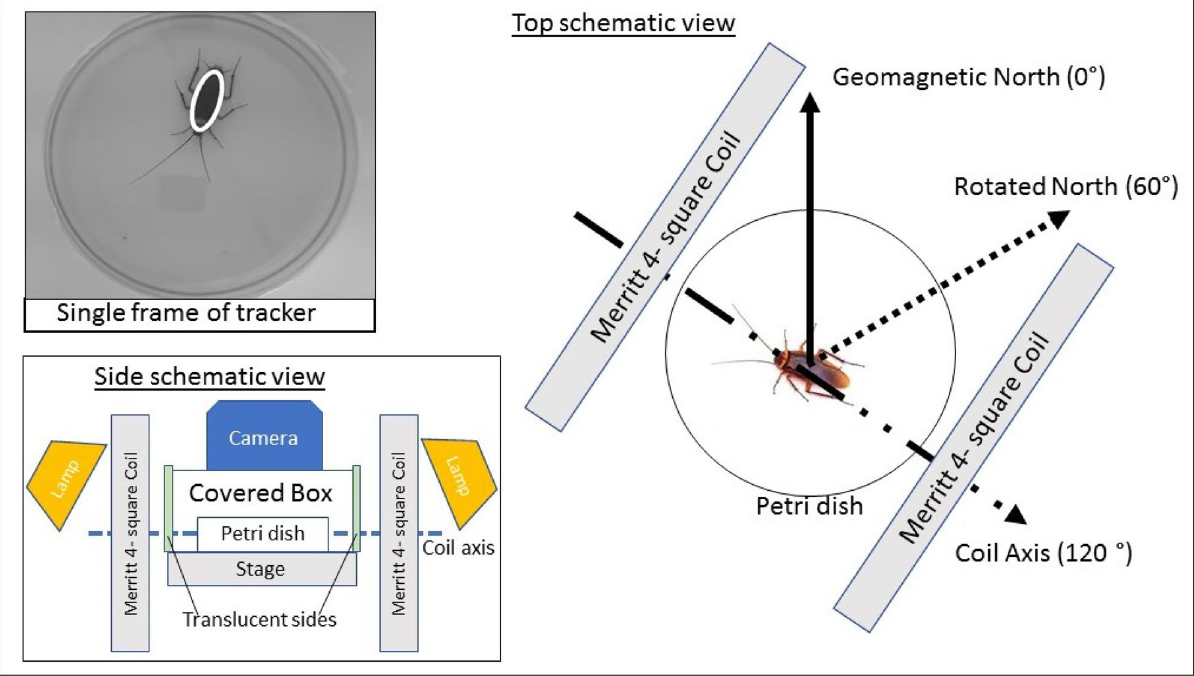
Figure 1. Schematic of experimental setup (not to scale). Cockroaches were placed in Petri dishes and levelled ◦ ± 5 ◦ inside the Merritt coil used to rotate the geomagnetic field by 60 clockwise (preserving inclination angle, i.e. only horizontal component of the geomagnetic field is modified). The coil alternates between being switched on and off every 5 min, from 6 am to 6 pm. A camera records cockroach motion from the top of a covered box prepared to minimise visual cues from surrounding (bottom left inset). Tracking software recognises the insect (top left inset showing ellipse fitted to the cockroach) and stores its location and angle in the horizontal plane. Our figure of merit is the activity time defined as the time a cockroach spends translating or